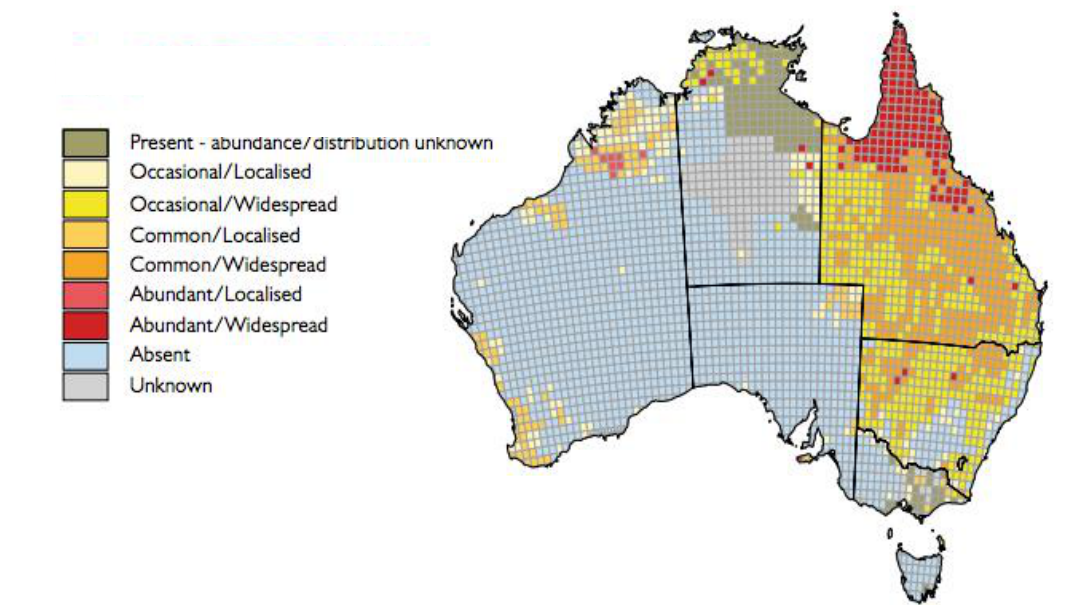
Figure 5. Map of Australia showing the occurrence, distribution and abundance of feral pigs ( Sus scrofa ) in Australia. Map generously provided by Invasive Animals Ltd. (Canberra Bruce, Australia)/Centre for Invasive Species Solutions.